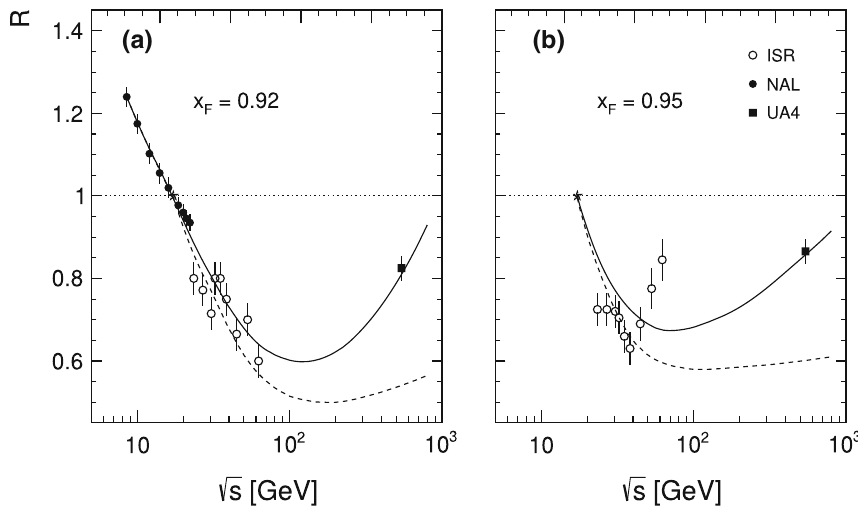
Fig. 134 Ratio of proton cross sections R relative to NA49 data √ s in the as a function of diffractive sector at x F = 0.92 and 0.95 including data from UA4 [94]. The full lines correspond to the invariant cross sections, the broken lines to the cross sections per inelastic